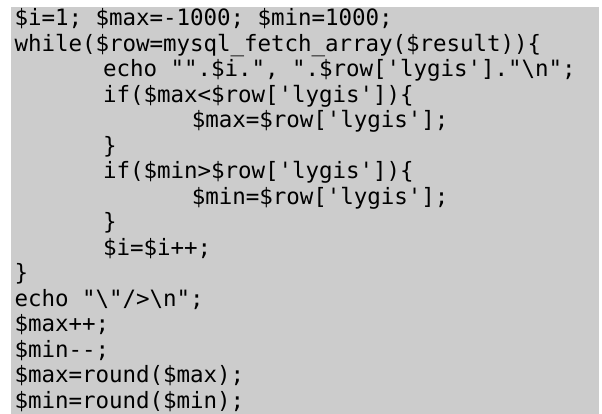
Fig 6. Excerpt from PHP